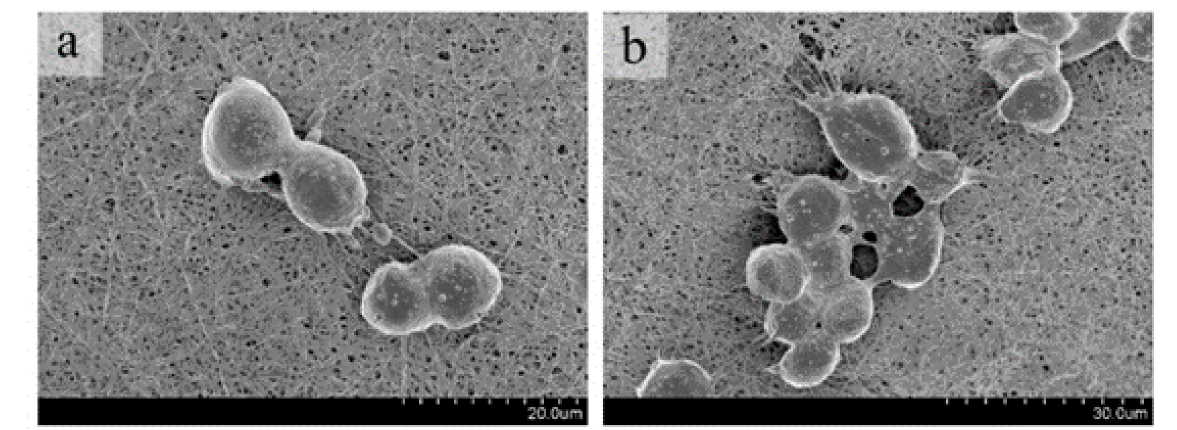
Figure 7. Cell-material co-culture. ( a ) cell division and proliferation, ( b ) cell